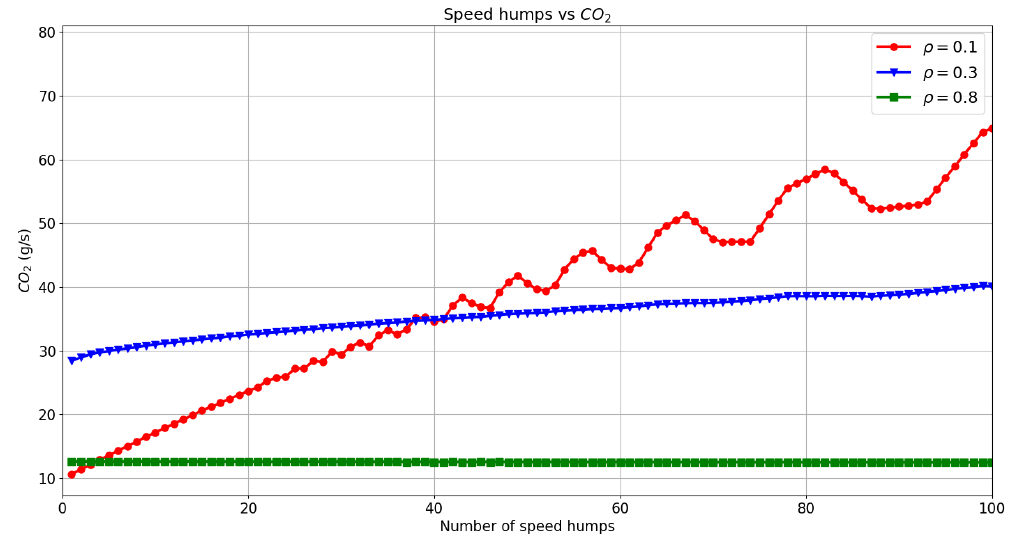
Figure 8. CO 2 instant emissions as a function of the number of speed